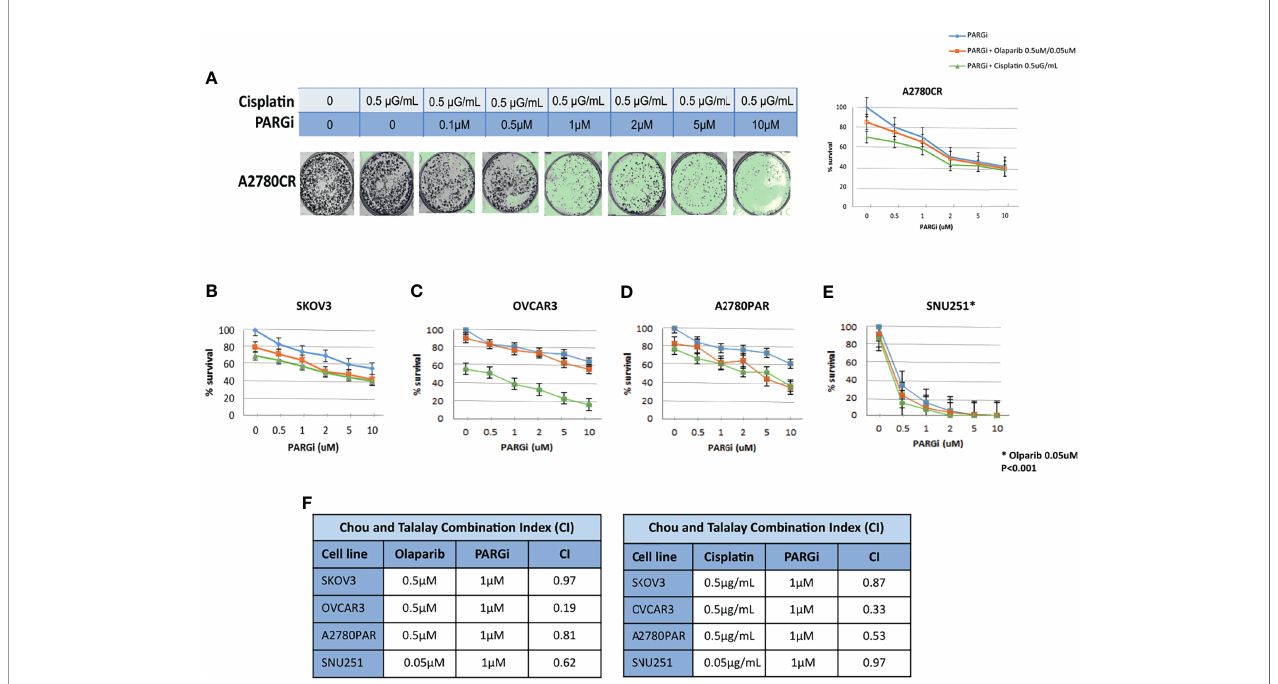
FIGURE 4 | PARG inhibitor (PARGi) sensitizes ovarian cancer cells to Olaparib and Cisplatin. Survival curves: Blue- increasing doses of PARGi 0, 0.5, 1, 2, 5, and 10 m M. Orange- increasing doses of PARGi 0, 0.5, 1, 2, 5, and 10 m M + Olaparib 0.5 m M (0.05 m M for SNU251). Green- increasing doses of PARGi 0, 0.5, 1, 2, 5, and 10 m M + Cisplatin 0.5 m g/mL In a clonogenic assay at day 7-10, the sensitivity to combination treatments including(PARGi+Olaparib) and (PARGi+Cisplatin) is higher compared to PARGi, Olaparib and Cisplatin alone. PARGi re-synthesize A2780CR to Cisplatin (A) . BRCA mutated cells “ SNU251 ” (E) were more sensitive compared to BRCA wild-type cells “ SKOV3 ” “ OVCAR3 ” “ A2780PAR ” (B – D) . The evaluation of combination index (CI) for PARGi, Olaparib and Cisplatin (F) was calculated where CI<1 indicates synergy between the drugs and CI>1 indicates an additive effect. Results are presented as means ± SEM for triplicates of three independent experiments.*p < 0.001, Olaparib dose